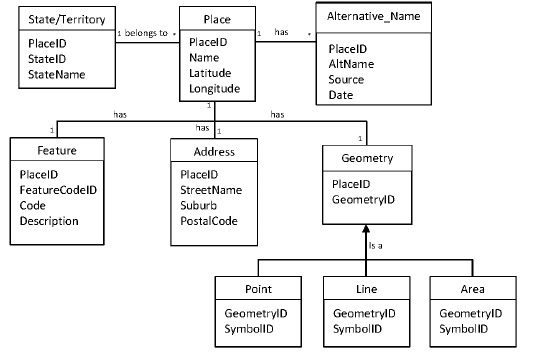
Figure 3. Simplified schema used in ontological Queensland